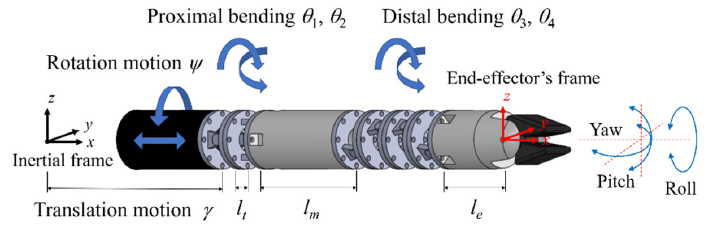
Figure 5. Articulated joints robotic arm with double segments .